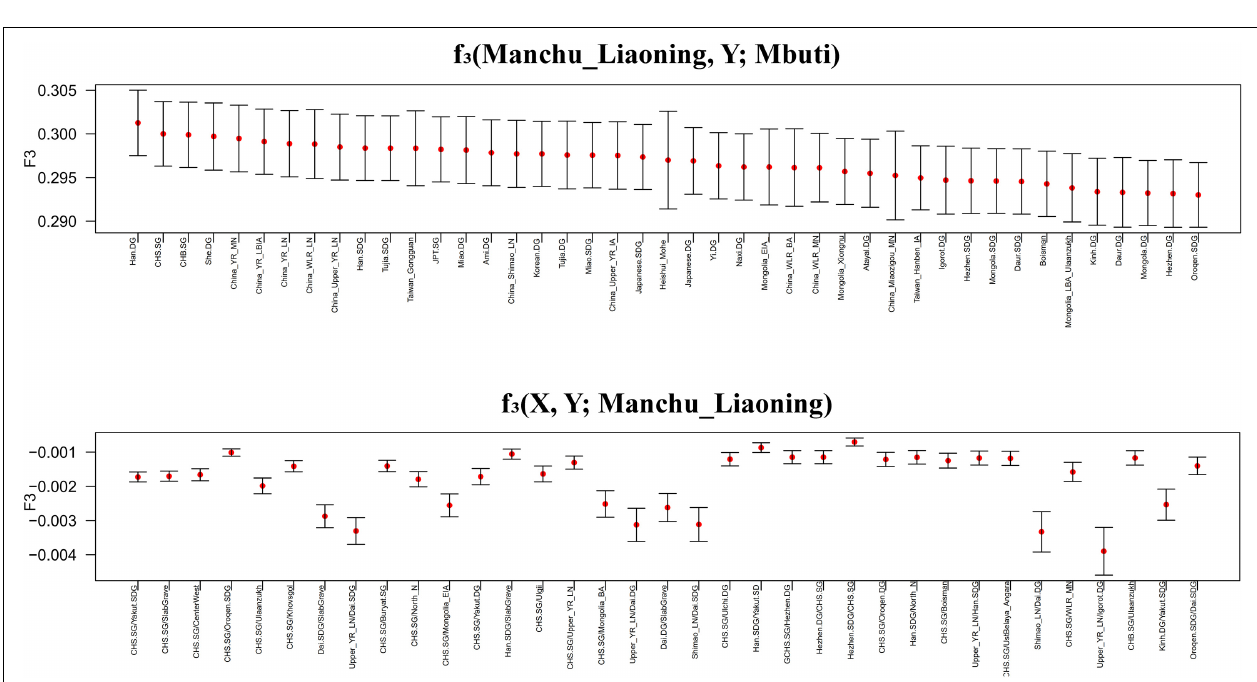
FIGURE 5 | Shared genetic drift estimated via f 3 -statistics in different testing forms based on the merged 1240K dataset focused on Liaoning Manchus. Bar denotes three times of the error bar.